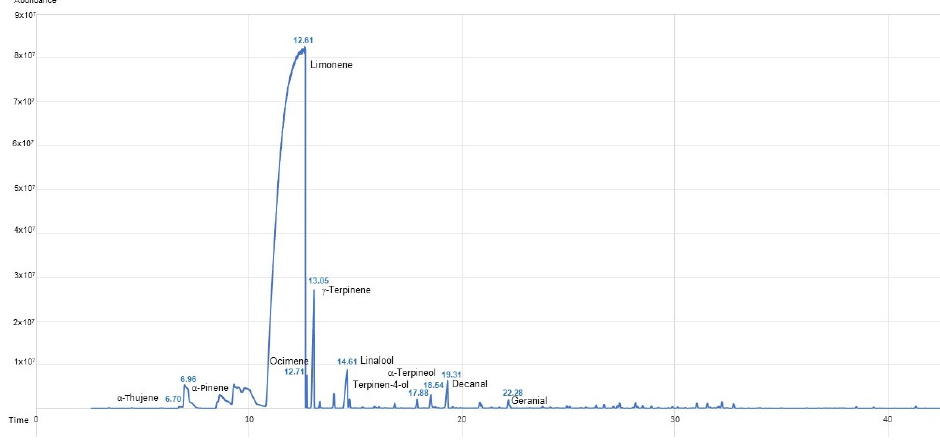
Figure 1. GC chromatogram of orange essential oil obtained using the cold-pressed method followed by steam distillation (EOPD). Table 1. Chemical constituents of essential oils obtained from fruit peels of Citrus sinensis (L.) Osbeck